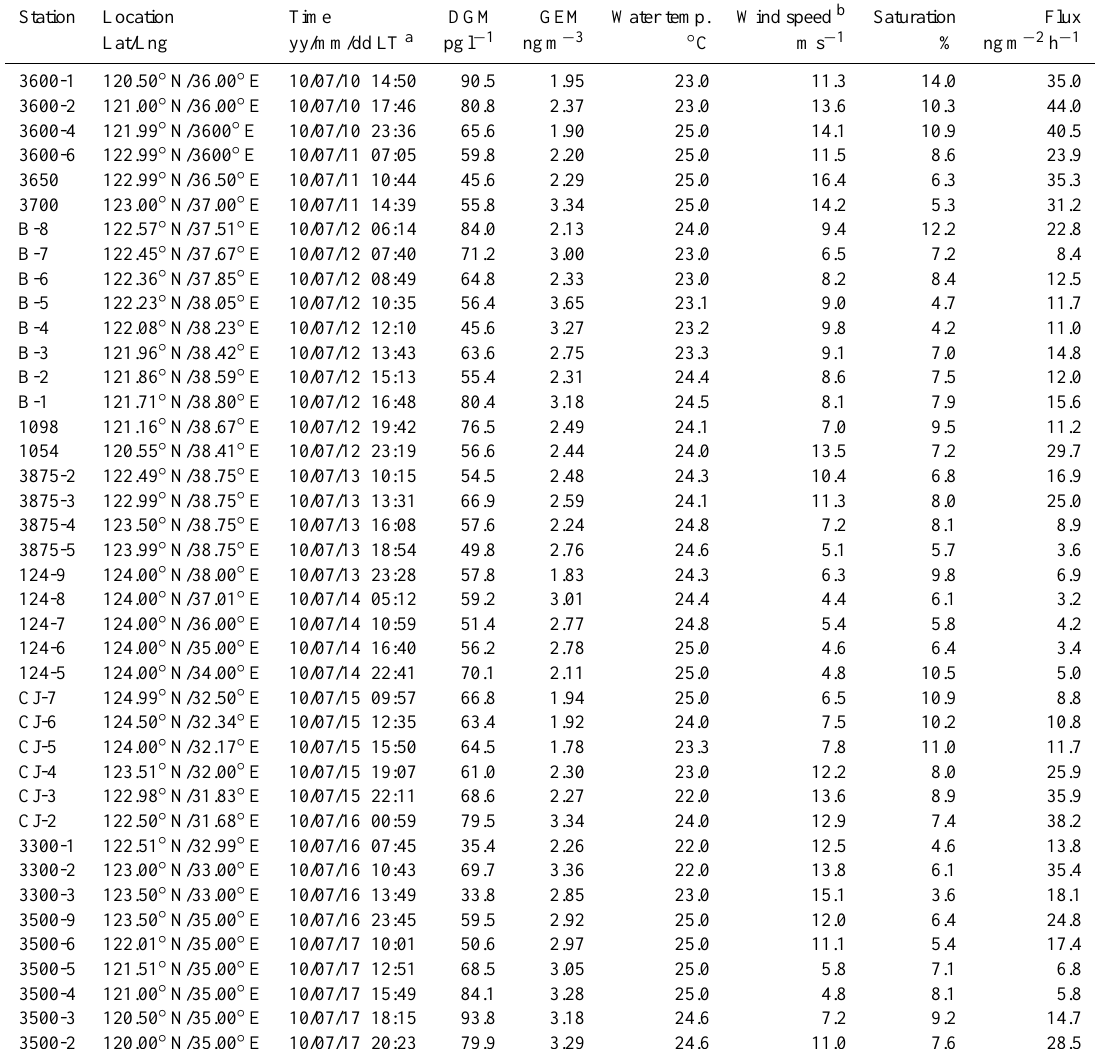
Table 1. Summary of station information, atmospheric GEM, surface water DGM and relevant data for air-sea Hg(0) flux calculation in the Yellow Sea during the cruise in July